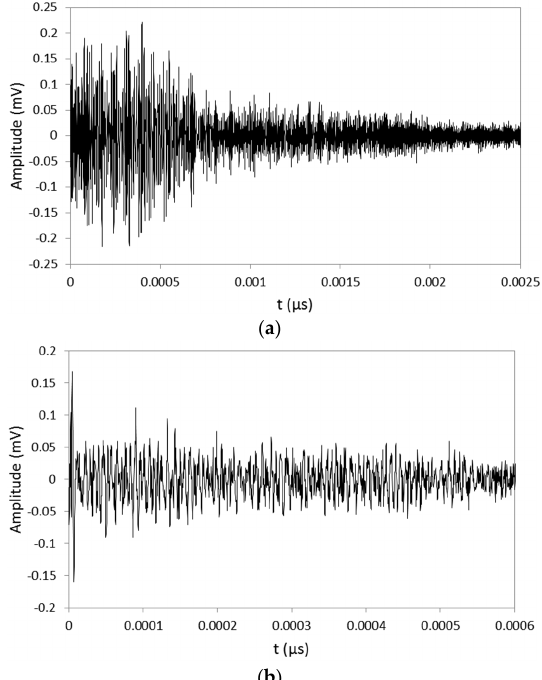
Figure 4. Signals designated as process-orientated AE burst ( a ) and AE burst indicating damage ( b ).